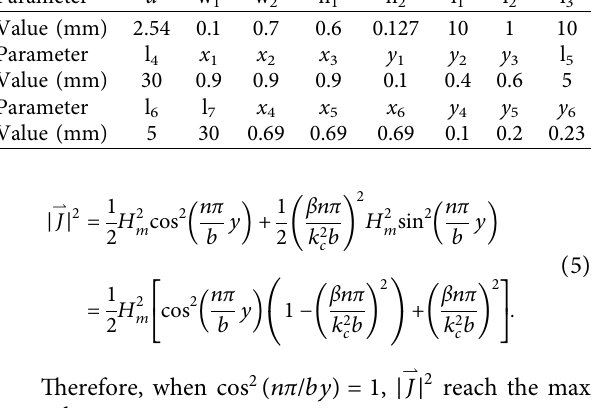
Table 1: Dimensions of the SRW and the feeding structure.